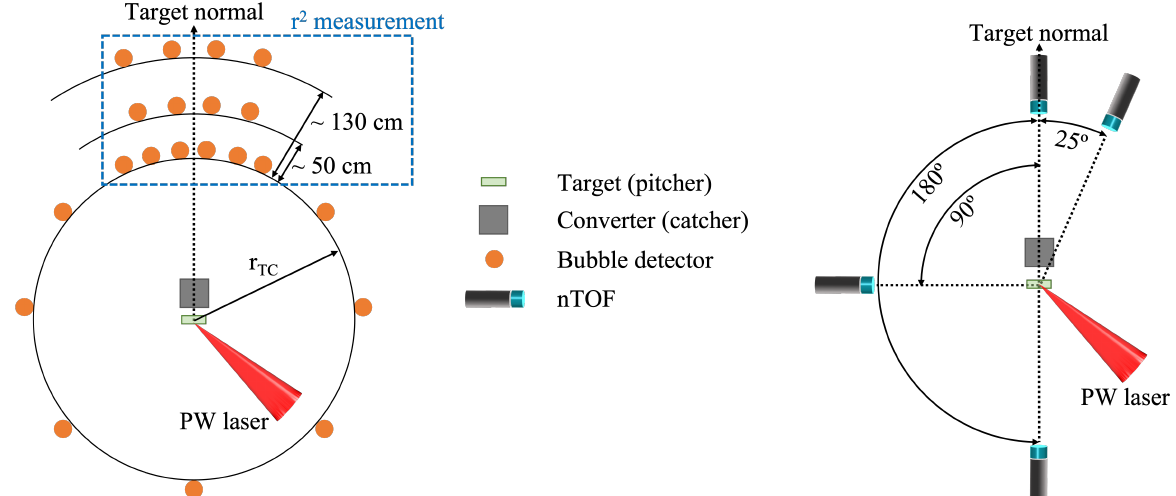
Figure 5. Setup for the neutron flux measurement in the laser plane using bubble detectors ( left ). The energy spectrum is measured using neutron time-of-flight detectors at selected angles ( right